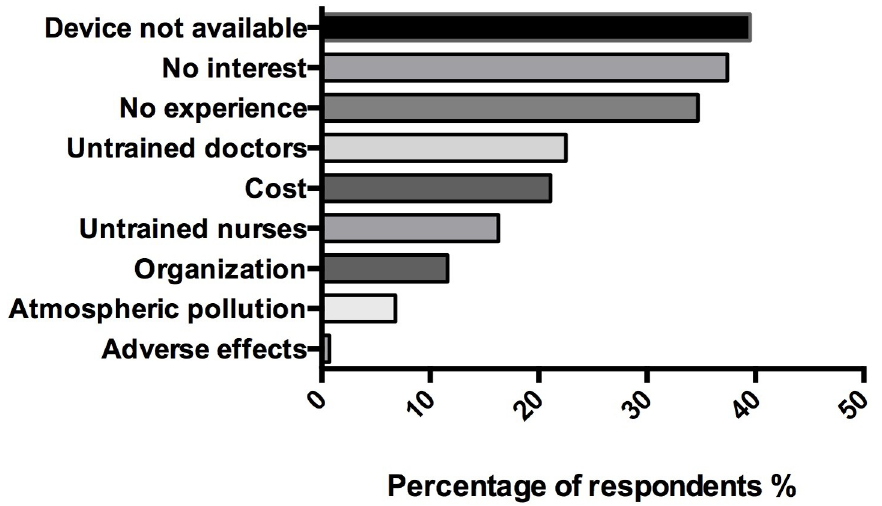
Fig 2. Reasons reported for not using inhaled sedation in surveyed intensive care units. (n = 147) Data are represented in %